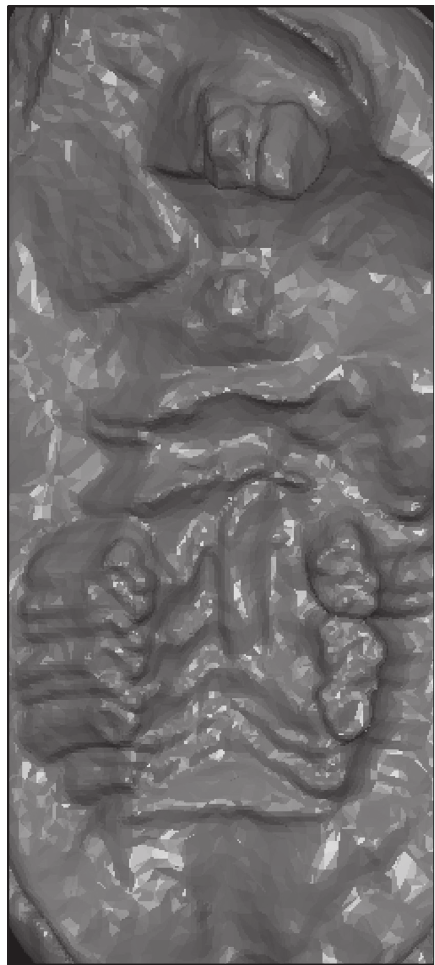
Figure 2: Three-dimensional scan of a sample subjected to MTX and orthodontic force in AB Viewer. The arrow indicates the amount of tooth movement.